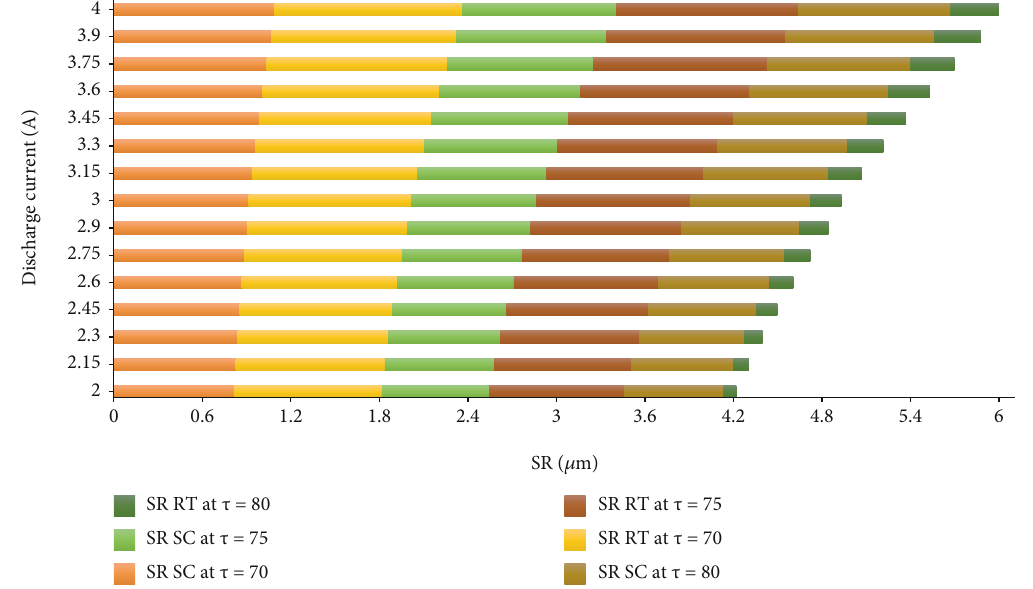
Figure 8: SR vs. discharge current for two types of electrodes at T